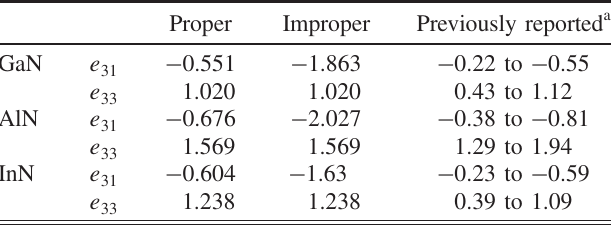
TABLE II. Calculated piezoelectric polarization constants in units of C = m 2 compared with reported values from the